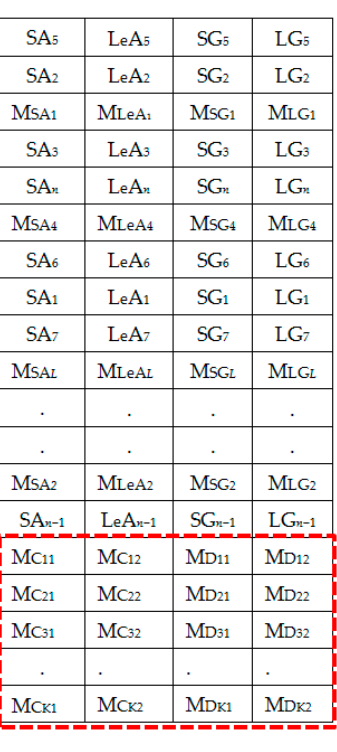
Figure 10. Generating local averages of the shuffled feature set.